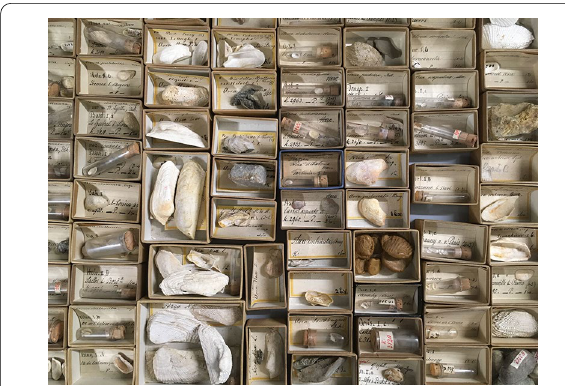
Fig. 4 Bivalves of the genus Arca in the systematic collection. Today, many of these are placed in different genera